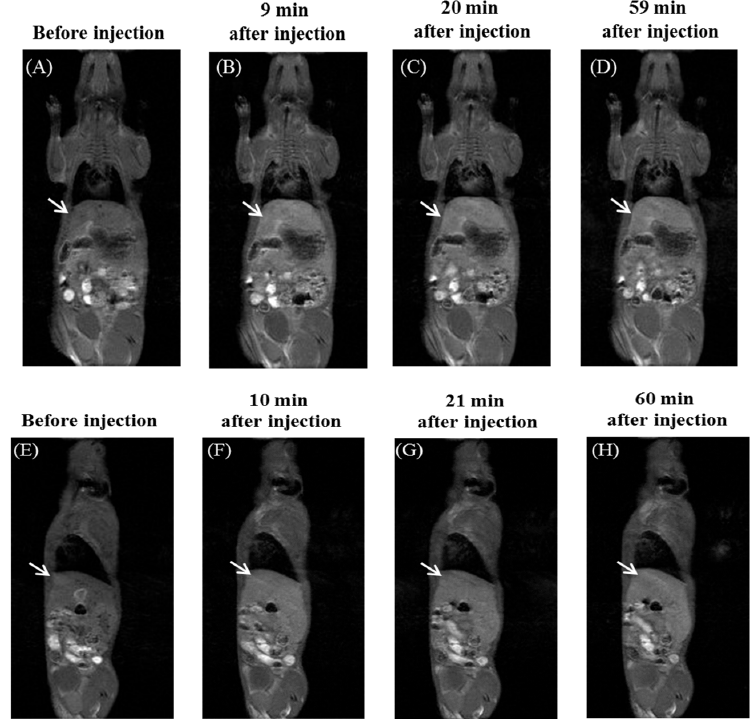
Figure 7. Time-course of coronal (panels A – D ) and sagittal (panels E – H ) T 1 -weighted MR images of an ICR mouse before and after injection of 200 µ L of 2 / 4 14 (40 mM) in PBS. Distinct contrast enhancement was observed in the liver of the mouse (indicated by white arrows). See the Supplementary Information for experimental details.